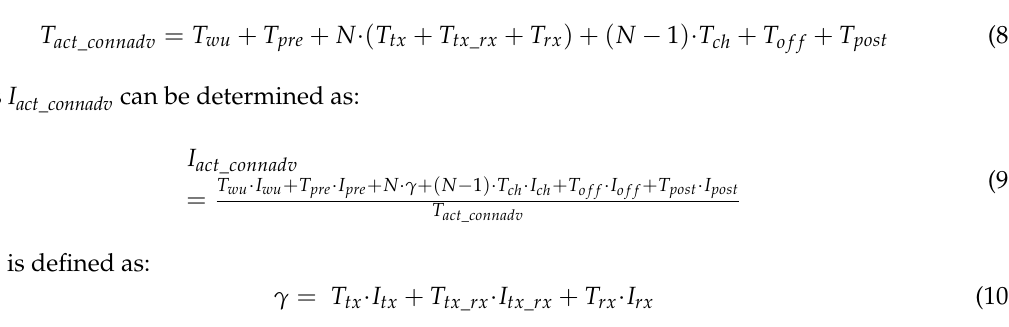
Figure 8. Illustration of the components related with connection establishment, use and finalization. S and M denote Slave and Master, respectively. A round trip exchange comprises a packet sent by the master to the slave, and the response sent by the latter.